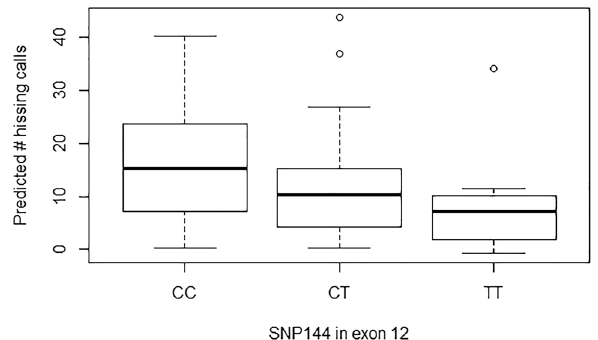
Figure 3. Quartile based box plots of the number of hissing calls produced by females in relation to exon 12 SNP144 genotype. Plotted are the number of hissing calls corrected for fixed and random effects included in the additive effect model (i.e. predicted values; see text for details). For illustration purposes, the estimates from the model with standardized hissing calls were back-transformed to the actual number of hissing calls produced. N females per genotype: CC: 238, CT: 56, TT: